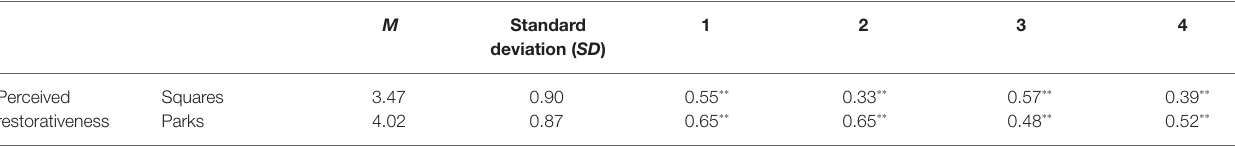
TABLE 6 | Descriptive statistics and correlations of the dependent variable for squares and parks.